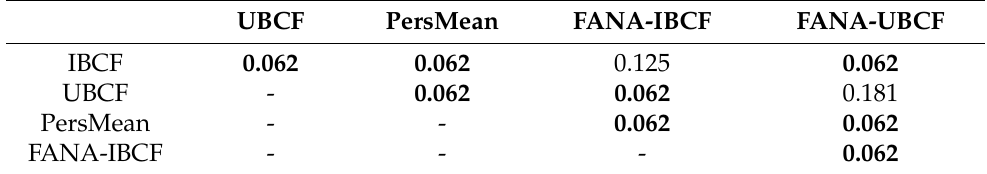
Table 4. Pairwise Wilcoxon signed-rank test of MAE performance among IBCF, UBCF, PersMean, and our proposed approach, FANA-CF. The results in bold are statistically significant with a 90% confidence